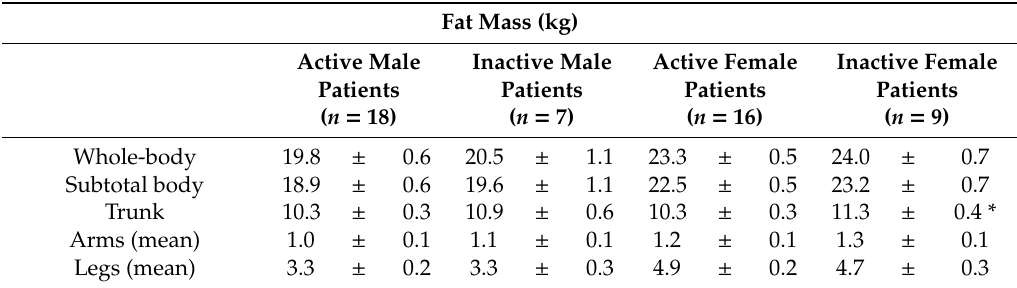
Table 4. Fat mass indices in McArdle patients by physical activity levels and sex.